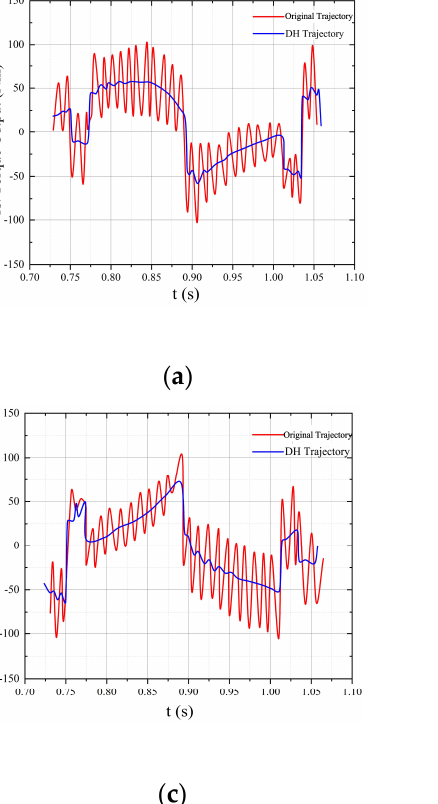
link; ( c ) and ( d ) torque of the right link.